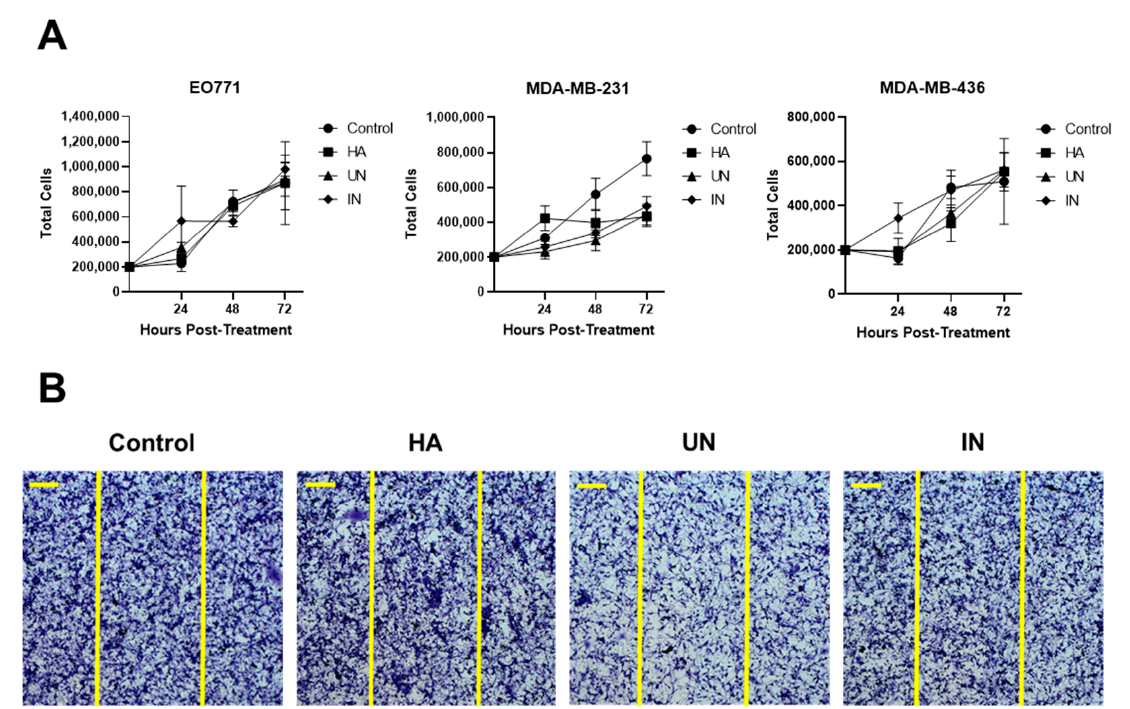
Figure 3. YS-HAse degradation products do not affect cell proliferation or migration. ( A ) Proliferation assay of 3 TNBC cell lines. YS-HAse cultures were grown to an OD 600 of 1.5 and centrifuged. Pellets were resuspended in LB-0 media containing 200 µ g/mL purified HA (LB-0-HA, and UN or IN with 2% L-ara overnight at 37 ◦ C. The supernatants were collected and added to 12-well plates seeded with 2 × 10 5 EO771, MDA-MB-231, or MDA-MB-436 cells. The control wells received media and L-ara; the HA wells received L-ara and LB-0-HA media. All wells received 1.5 µ g/mL gentamicin. The cell counts were performed in triplicate at the indicated timepoints. ( B ) The scratch test assay of MDA-MB-231. The MDA-MB-231 cells were seeded and treatments were prepared as in ( A ). When the cells were confluent, a p200 pipette tip was used to make a vertical scratch through the well. Vertical yellow lines represent the initial width of the scratch. When the control well fully closed, all other wells were stained with crystal violet and imaged using brightfield microscopy. Scale bar = 200 µ